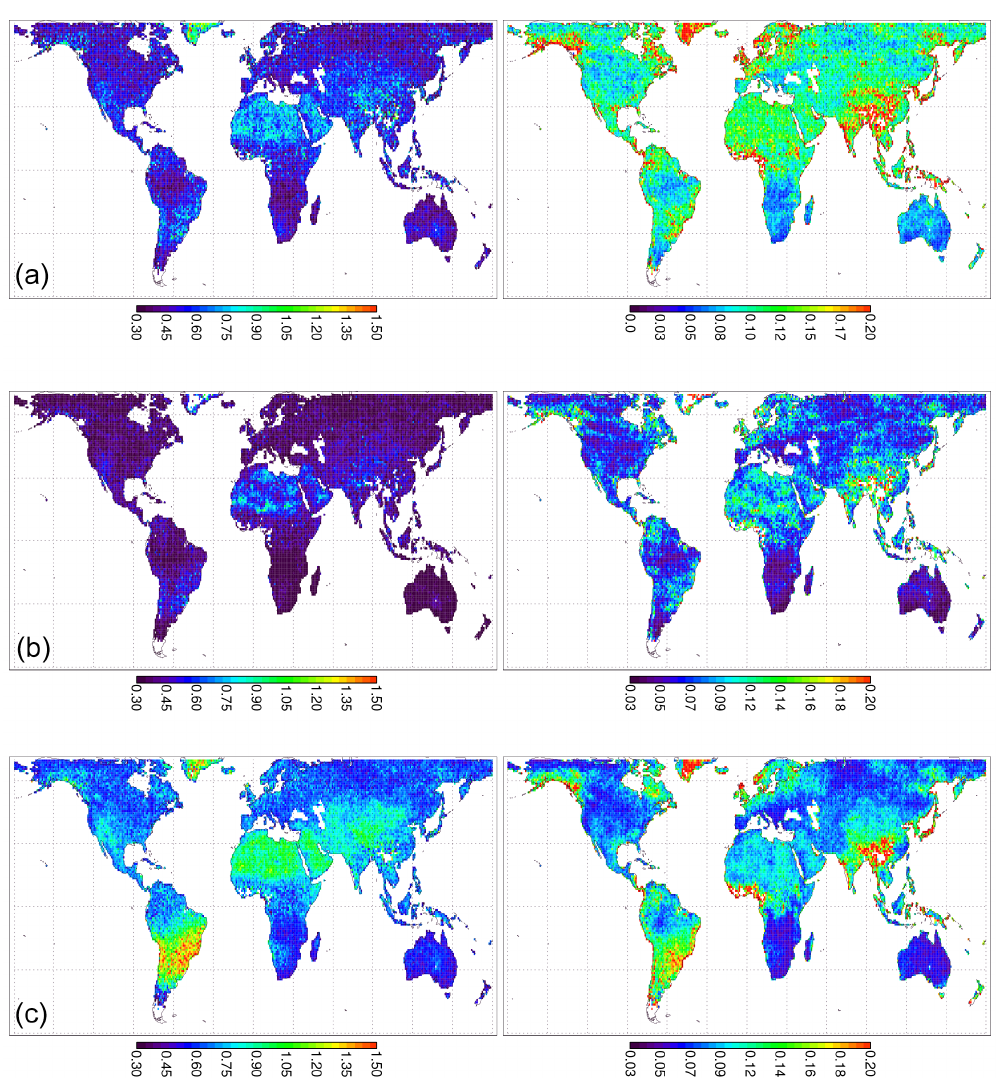
◦ grid cells for July 2007. Figure 9. Global maps of red SIF retrieval statistical parameters in 1 (a) Grid cell standard deviation (left) and standard error (right) for SCIAMACHY SFL red SIF retrievals in mWm − 2 nm − 1 sr − 1 (682–686.5nm). (b) Similar to (a) but for SCIAMACHY O 2 -band red SIF retrievals (622–640 and 682–692nm). (c) Similar to (b) but for GOME-2 red SIF retrievals using 622–640 and